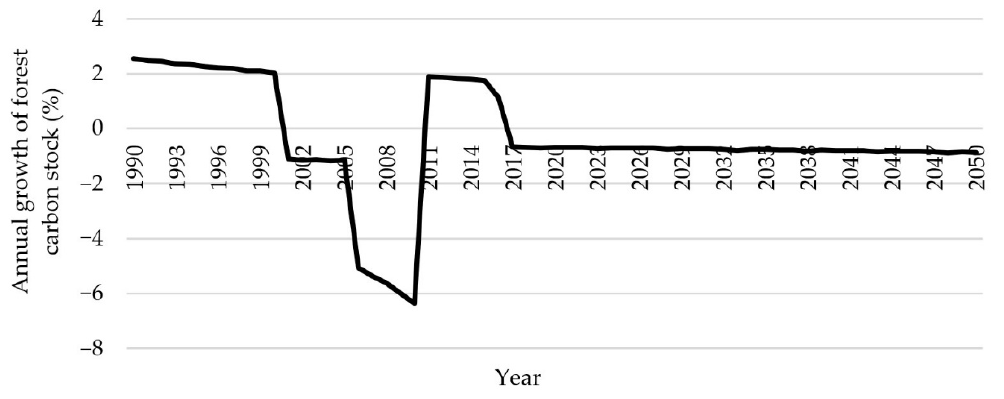
Figure 5. Change and prediction in annual increment rate of forest biomass carbon stock in Malaysia .